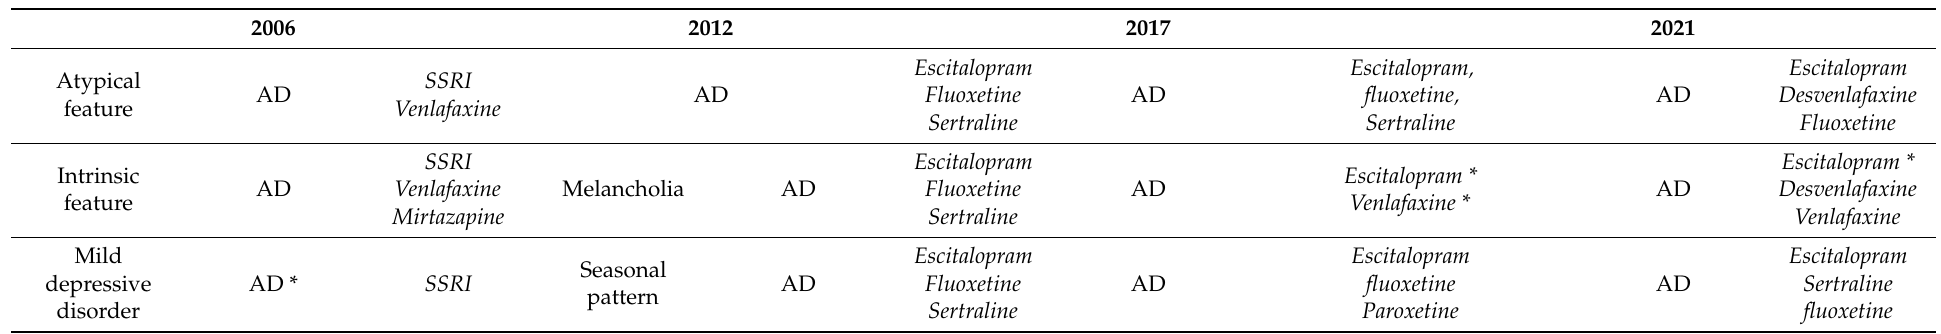
Table 3. First-line treatment strategies for the subtypes of depression of